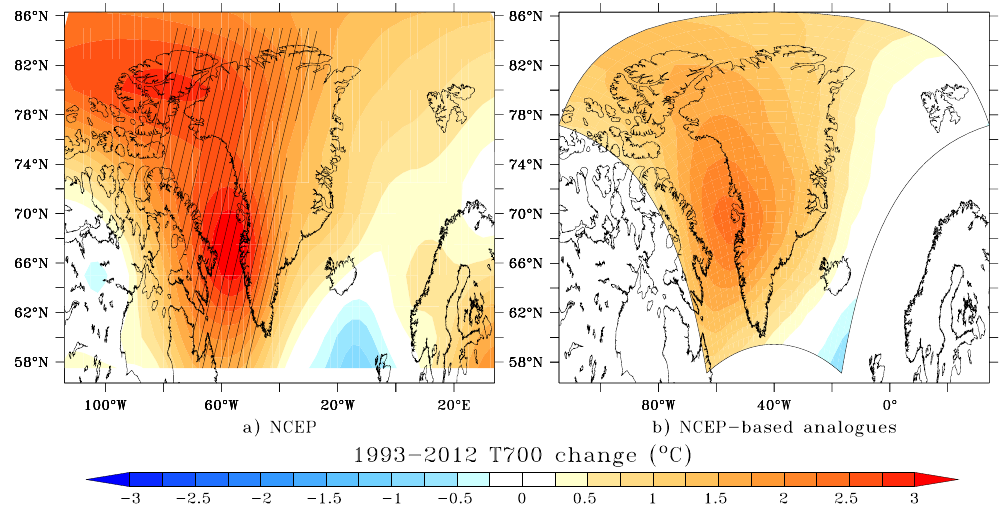
Fig. 2. (a) The JJA T700 changes over 1993–2012 based on a linear regression using the NCEP-NCAR reanalysis. The areas where the changes are two times above the 1961–1990 JJA T700 standard deviation are hatched. (b) The same as (a) but derived using the NCEP- NCAR-based T700